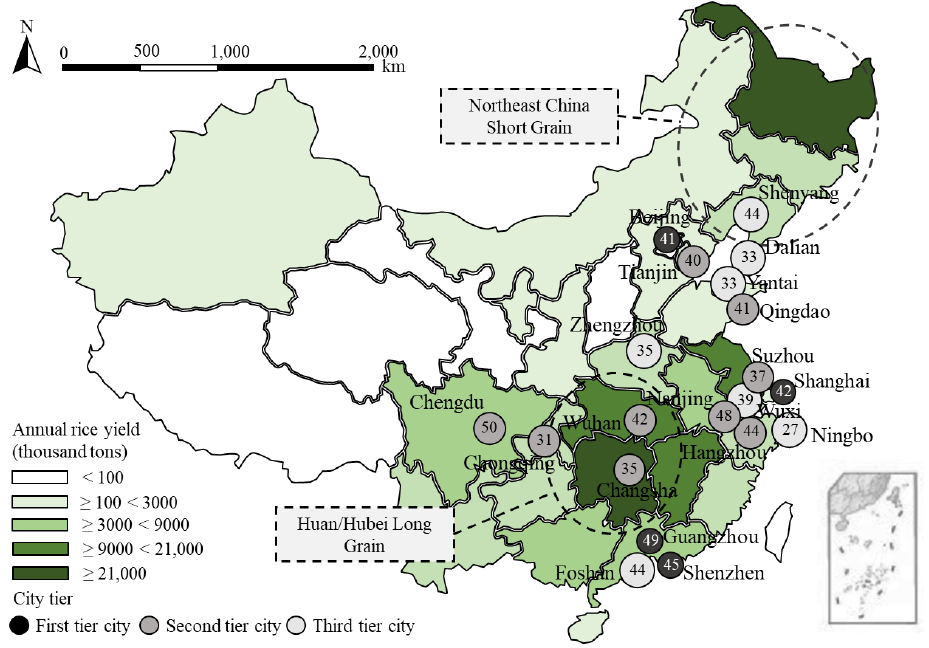
Figure 2. The production of rice by province in China and the distribution of samples in cities. Note: The number in the circle is the number of valid questionnaires collected from that city; the areas shown in dotted circles are the locations and names of the two rice-producing areas in China designed in our choice experiments.